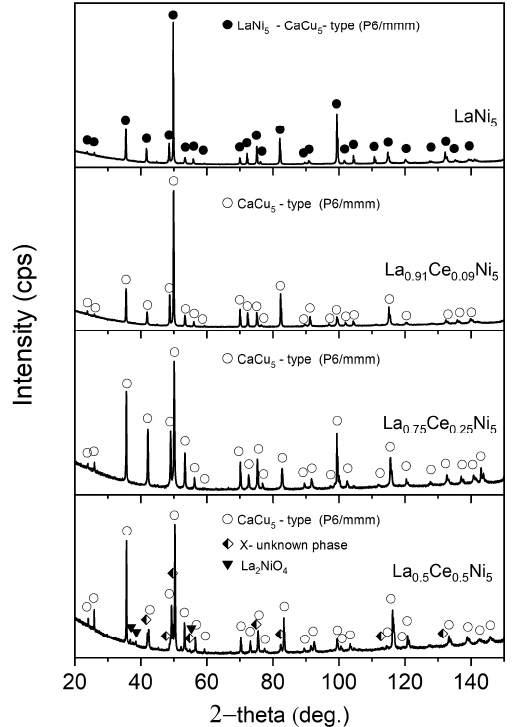
Figure 1. X-ray di ff raction (XRD) patterns of the investigated Figure 1. X-ray diffraction (XRD) patterns of the investigated alloys.